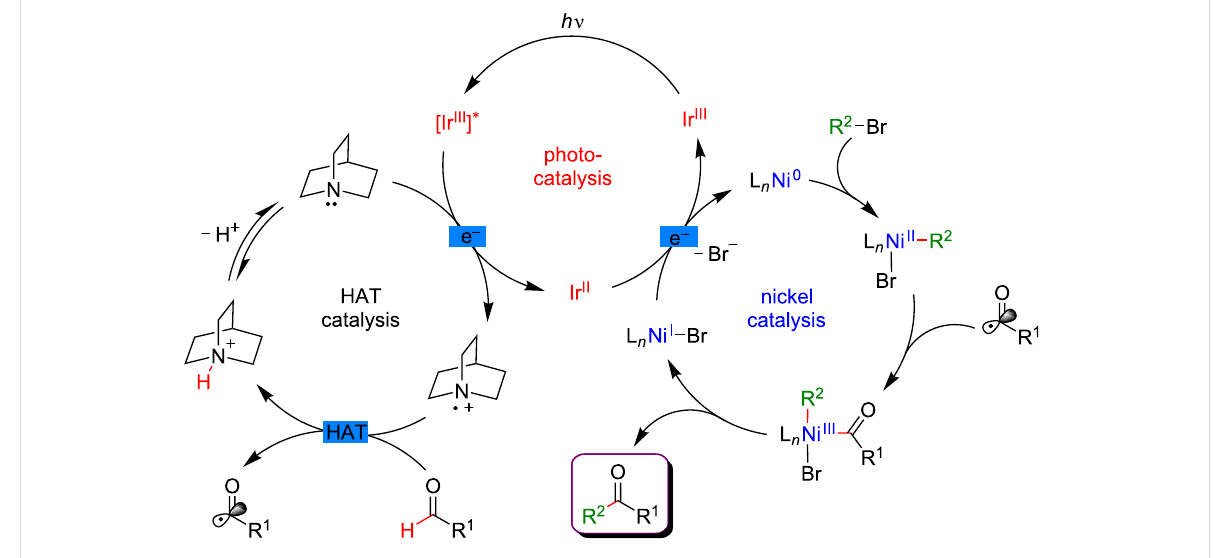
Figure 76: Proposed mechanism for the C–H functionalization of aldehydes promoted by HAT.